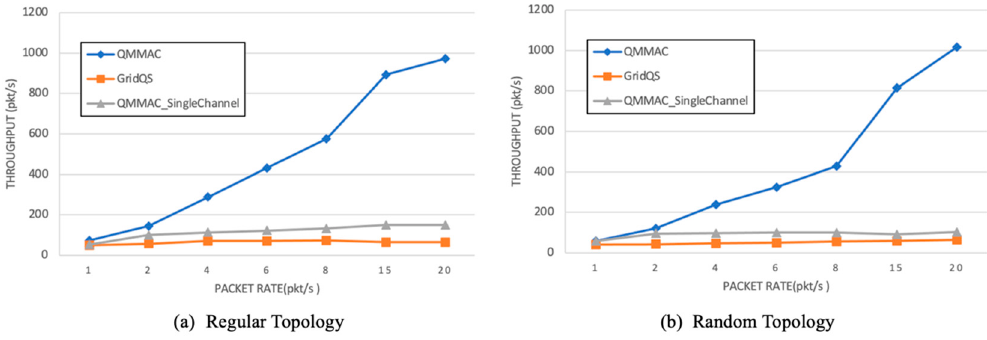
Figure 14. Throughput.